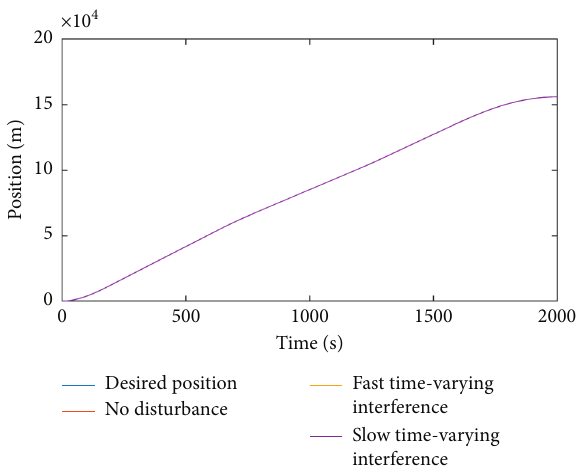
Figure 16: Position tracking error of the HST.